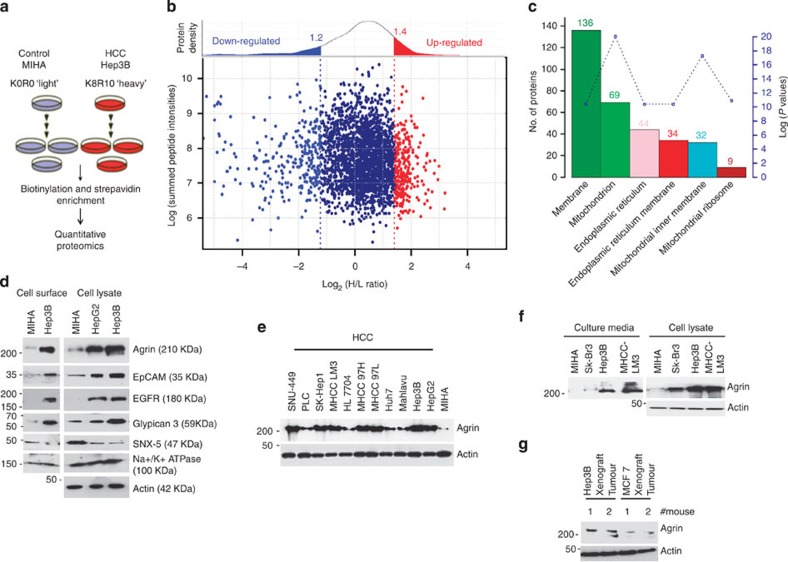
Identification of Agrin as an overexpressed cell surface protein in HCC cell lines.(a) Schematic workflow of SILAC mass spectrometry-based analysis of cell surface proteins, where MIHA and Hep3B cells are labelled with ‘light’ and ‘heavy’ amino acids, respectively, and vice-versa. (b) The ratio intensity plot representing protein fold change (SILAC ratio versus corresponding summed peptide intensity distribution) and protein density plot (upper panel). Red, blue and navy-blue cluster indicates up-, down- and unregulated proteins. (c) Gene ontology Cellular Component analysis of upregulated proteins in Hep3B cells. The scale bar (y axis right hand side) indicates the P values, while the numbers on top of each bar denotes the abundance of identified proteins in the particular cellular component. (d) Biotinylated cell surface proteins and total cell lysates from the indicated cell lines were analysed by western blot analysis using the indicated primary antibodies. (e) Western blot analysis of Agrin expression in non-tumorigenic MIHA and various HCC cell lines. β-Actin was used as loading control. (f) Conditioned medium from serum-starved (12 h) cell lines were concentrated and precipitated with trichloroacetic acid and analysed by western blot for secreted Agrin. Total cell lysates from the same cell lines were also probed for Agrin with β-actin as a loading control. (g) Levels of Agrin in mouse xenografts of indicated cell lines were analysed by western blot using an Agrin-specific monoclonal antibody. β-Actin served as loading control. H/L, heavy/light.